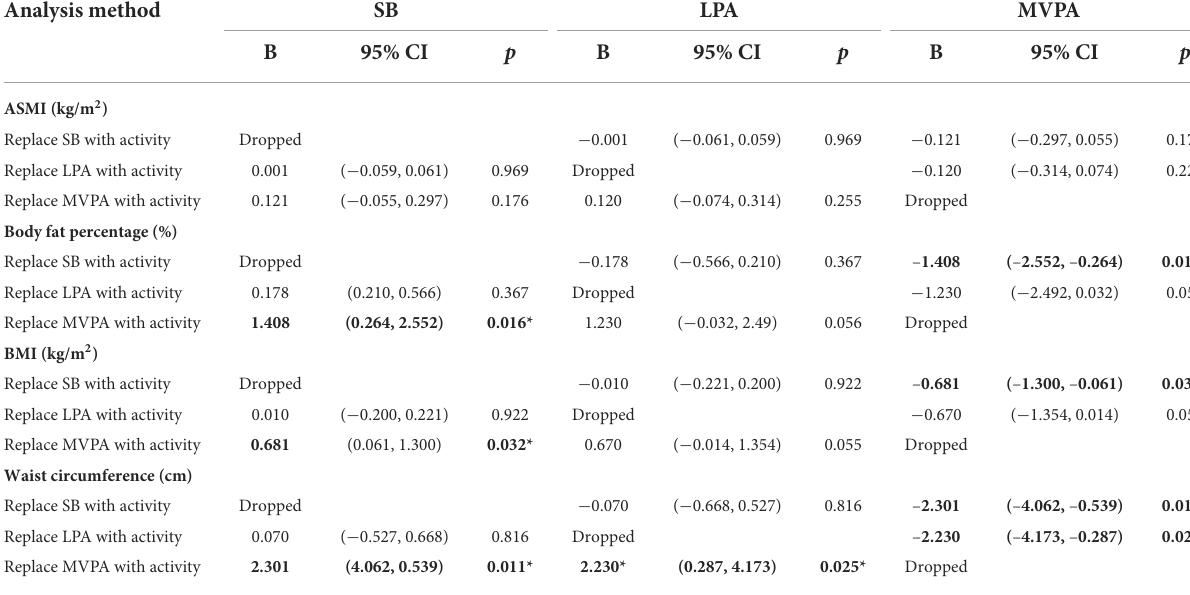
TABLE 3 Adjusted substitution models examining the associations of replacing 30min sedentary behavior, LPA and MVPA on body composition ( n = 199). Analysis